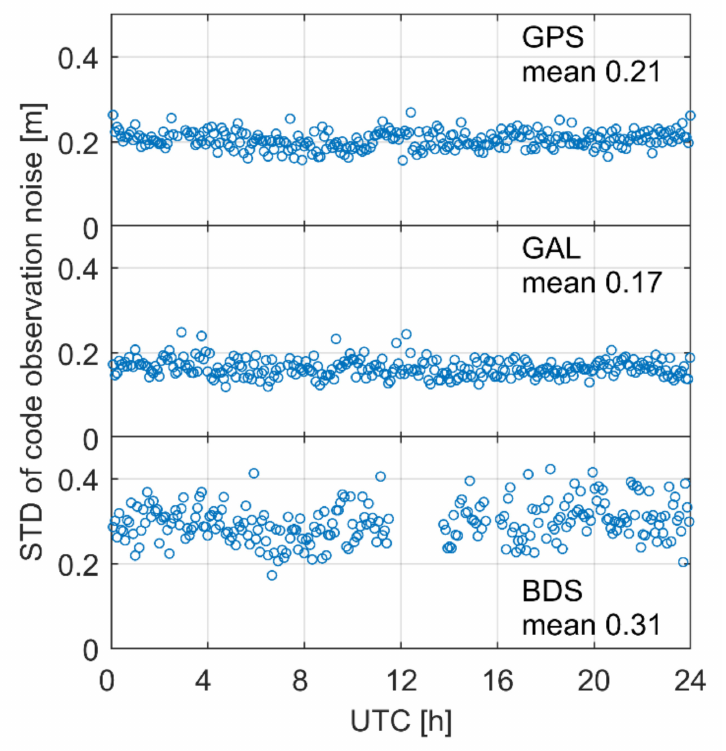
Figure 5. Estimated STD of the GPS, Galileo, and BDS SD code observation noise at the first frequency calculated using the IGG1–IGG2 baseline data collected on DOY 268,